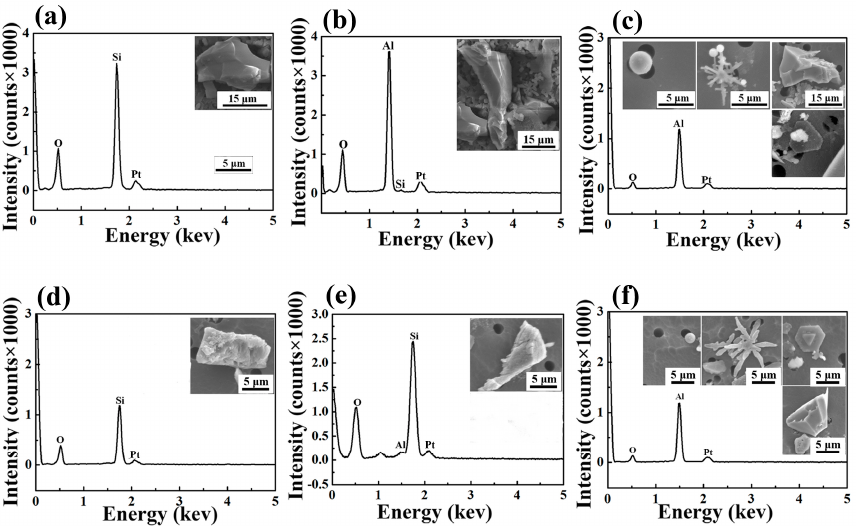
Figure 5. The type and three-dimensional images of Mn-Free oxides in S3 and S4 ( a ) SiO 2 in S3, ( b ) Al-Si oxide in S3, and ( c ) Al 2 O 3 in S3; ( d ) SiO 2 in S4, ( e ) Al-Si oxide in S4, and ( f ) Al 2 O 3 in S4.